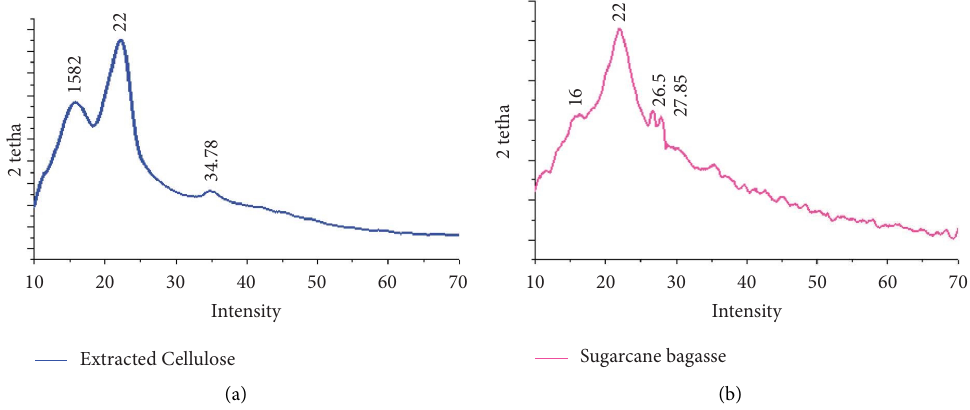
Figure 7: X-ray difraction pattern of (a) extracted cellulose and (b) untreated sugarcane bagasse. Table 4: Experimental analysis for gel content determination. Weight of dry gel Run no